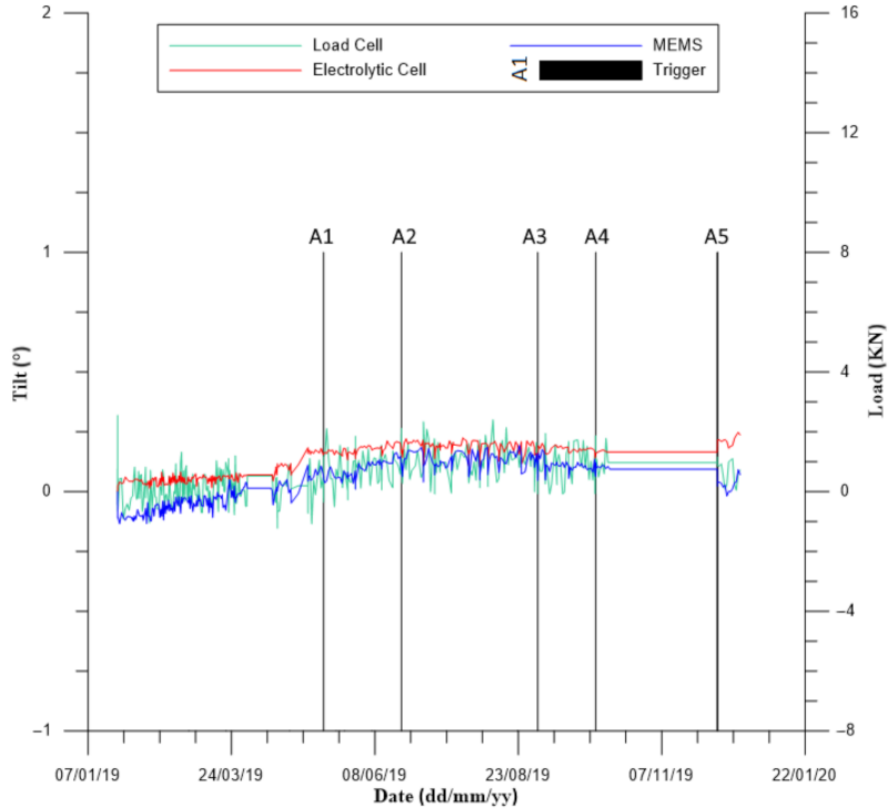
Figure 8. Trigger activations and related steel post tilt values recorded by MEMS and electro-level sensors, together with the mountain brace load identified by load cell